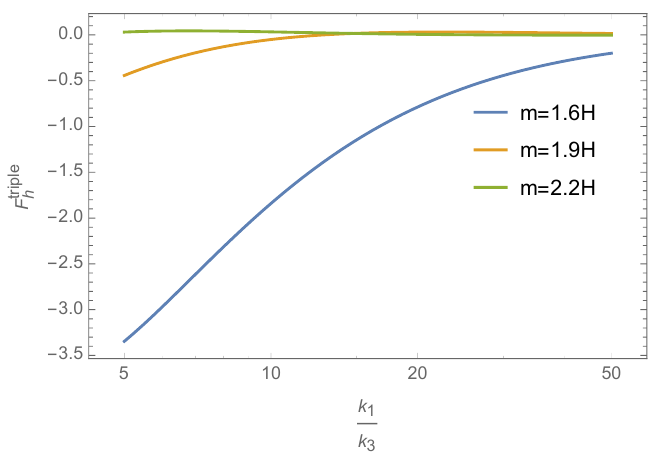
(2.18) for di(cid:11)erent masses in Goldstone h